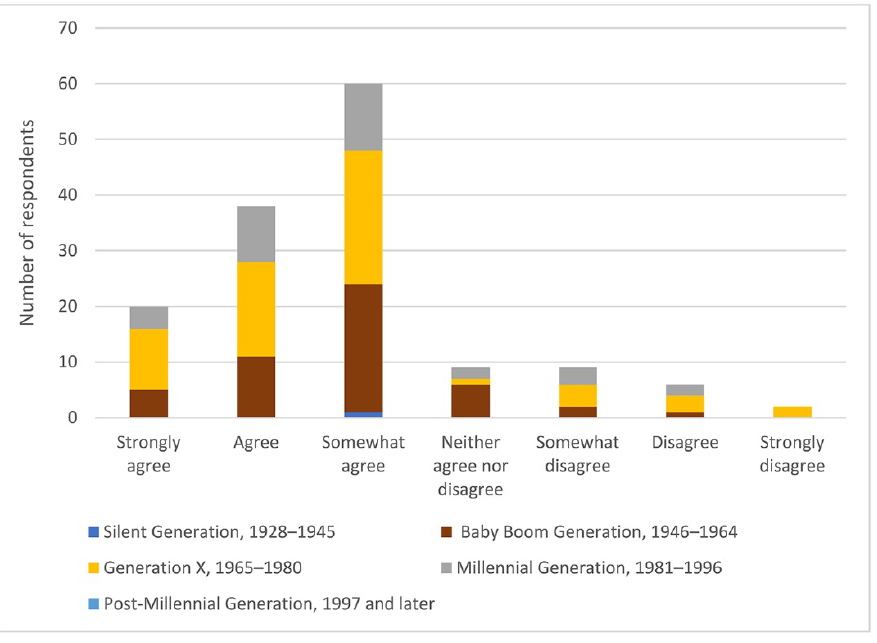
Figure 3 Respondents’ belief that age and/or generation has an impact on communication in the workplace based on respondents’ generation